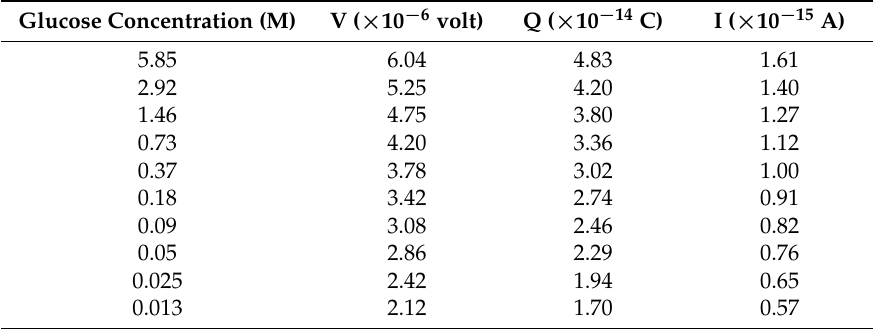
Table 4. The value of current, charge, and potential for various concentrations of glucose with a fixed enzyme concentration of 2,500,000